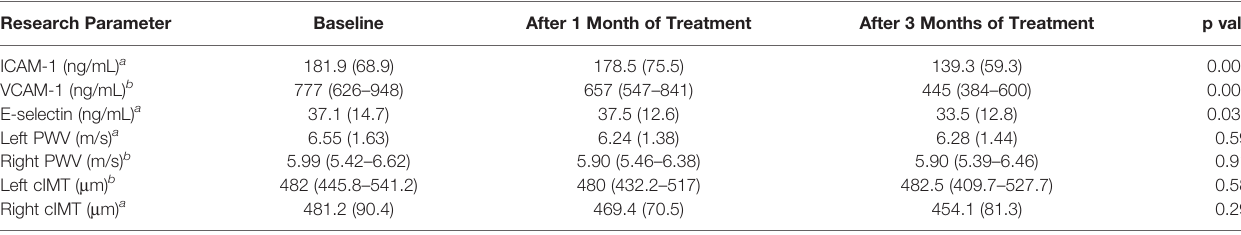
TABLE 2 | Changes in vascular atherosclerosis marker after 3 months of anti-thyroid treatment. Research Parameter Baseline